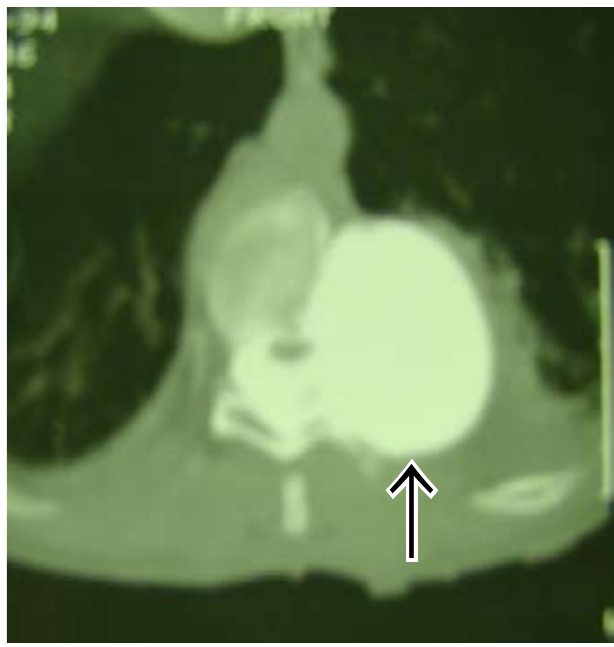
Fig. 12b. CT myelogram in the same patient demonstrating postero-lateral